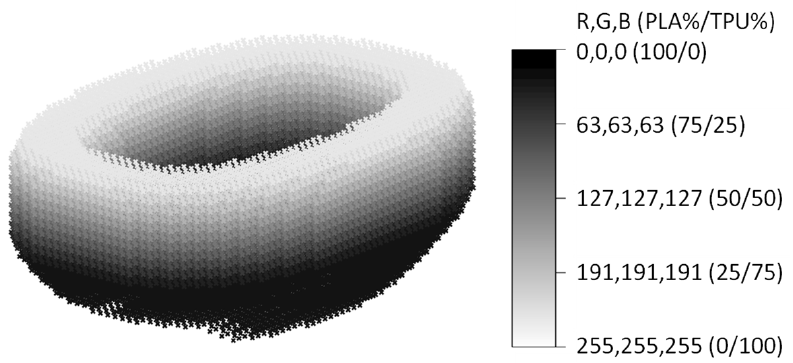
Figure 6. Point cloud of the volumetric information with different colors according to the material fraction.